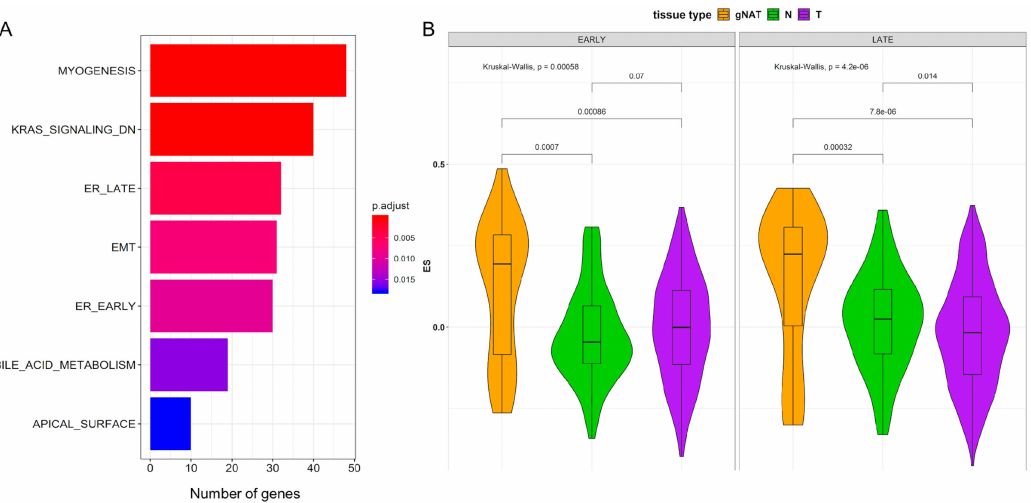
Figure 4. ( A ) GSA of the hallmark gene sets using the genes up regulated in gNAT vs. both the other 2 tissues. Adjusted p -value in red-blue color scale, ( B ) Violin plot of the hallmark early and late estrogen receptor (ER) pathways activity in gNAT, normal and tumor, respectively in orange, green and purple. ES obtained by gene set enrichment analysis